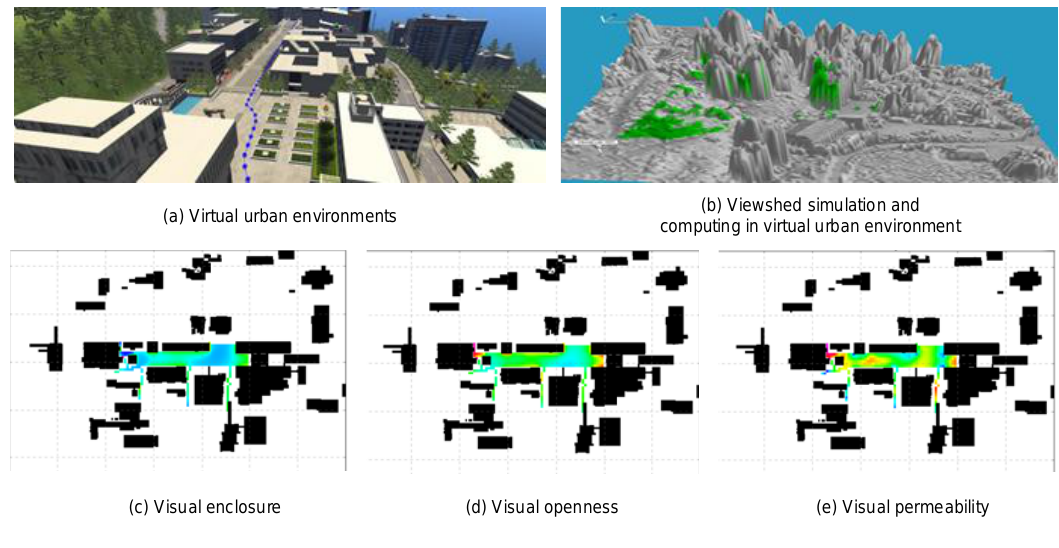
Figure 10. Controlled spatial relationships in virtual urban